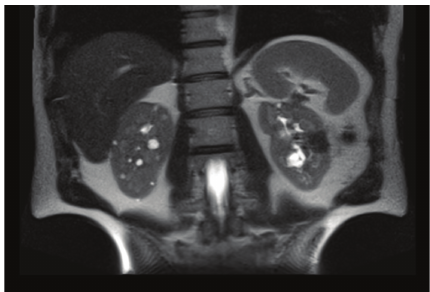
Figure 4: Abdominal MRI following two sessions of open surgery and radiofrequency ablation for a left-sided recurrent solid mass. There is no sign of recurrent or residual solid tumor in the kidneys. Remnant adrenal tissue on the left side was free of any recurrent lesion and was measuring 24.62 × 9.48 mm in diameter. Multiple cysts are visible in the right